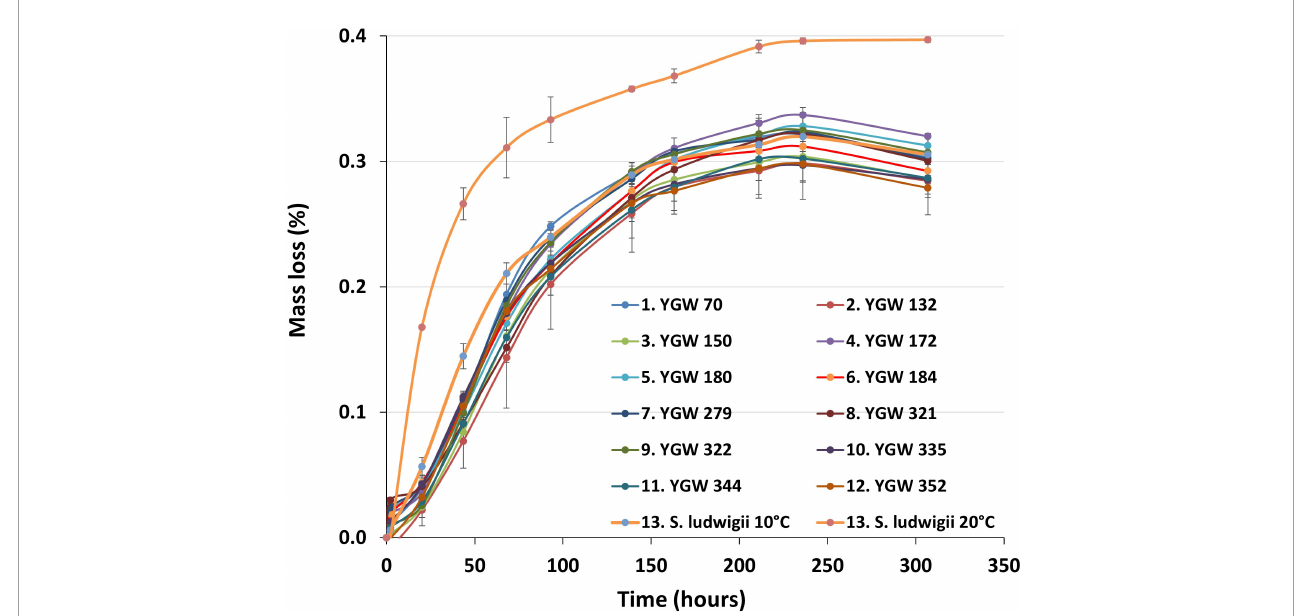
FIGURE1 Small-scale fermentation progress as measured by mass loss from 7.5 ◦ P wort fermented with strains of Mrakia gelida at 10 ◦ C. Reference conditions include Saccharomycodes ludwigii incubated at 10 ◦ C and 20 ◦ C. Values are means of two independent replicate fermentations ( ± standard deviation).